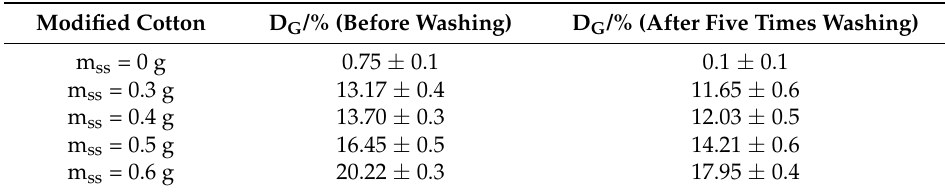
Table 2. Grafting degree of m ss = 0.5 g hydrogel modified cotton.